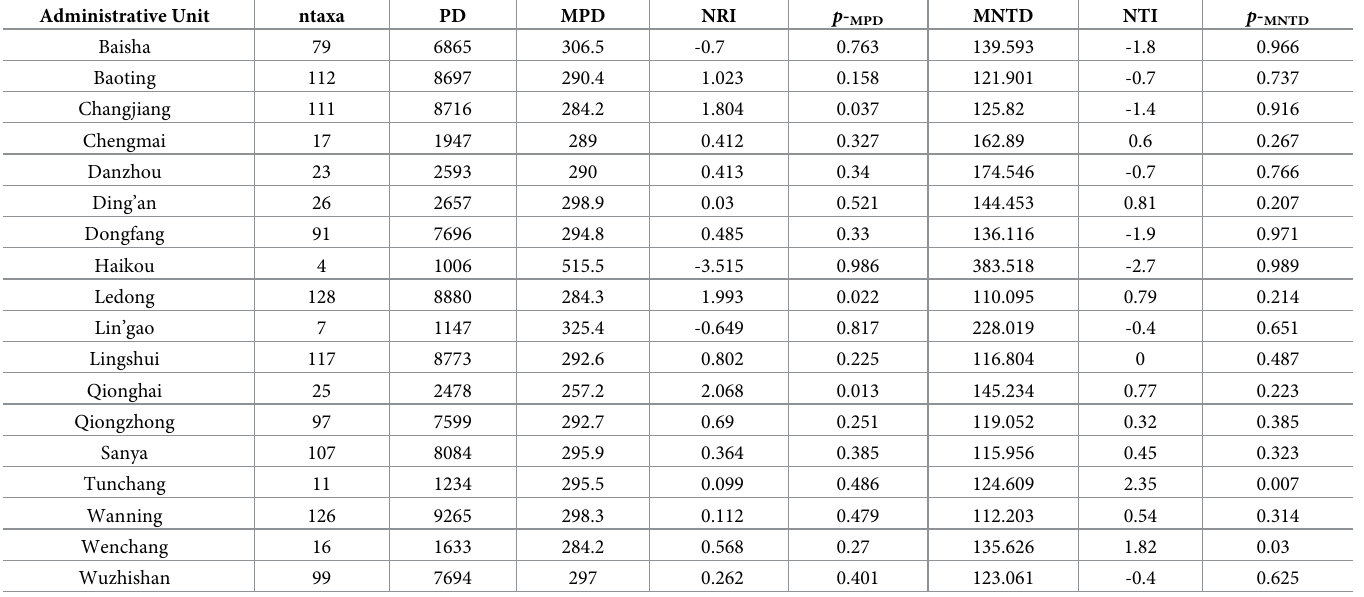
Table 4. The phylogenetic diversity (PD), mean phylogenetic distance (MPD) and mean nearest phylogenetic taxon distance (MNTD) of endemic plants in 18 administrative units of Hainan, China. Administrative Unit